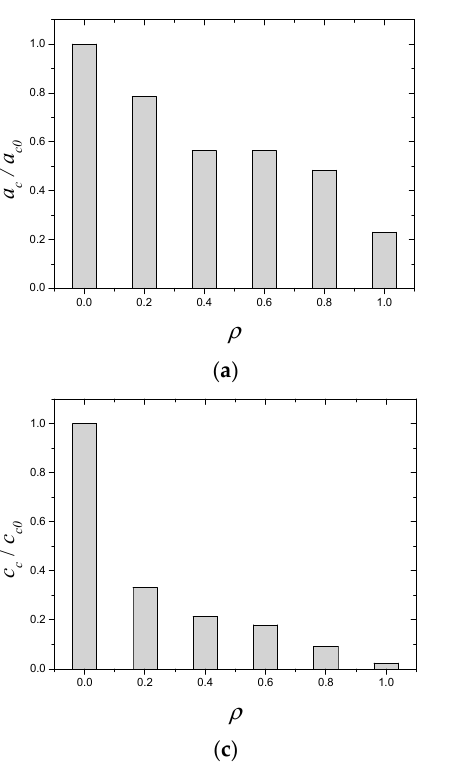
Figure 8. Early-age cracking performance of SWSSC mixtures with different ρ : ( a ) mean area per crack; ( b ) number of cracks per unit area; ( c ) total crack area per unit area; ( d ) coefficient of varia- tion . Table 7. Test results of early-age cracking performance.